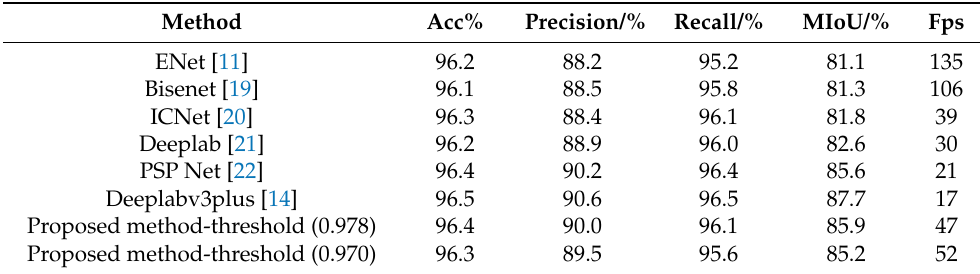
Table 1. Result of Tusimple data set.